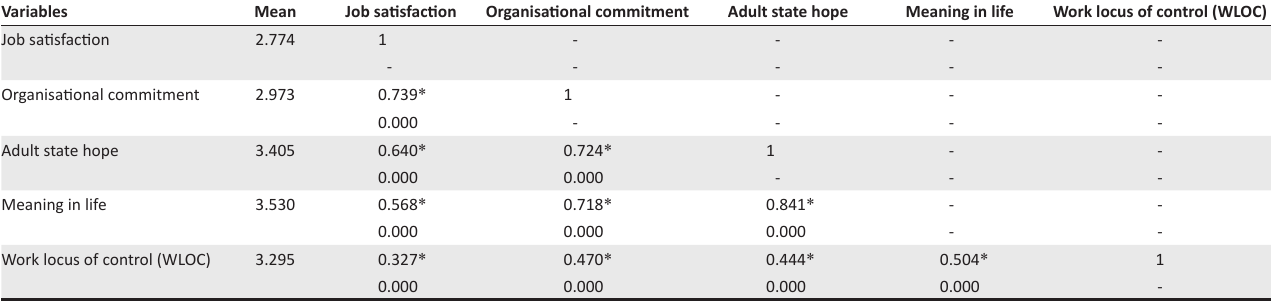
TABLE 1: Results of Pearson’s correlation analyses.